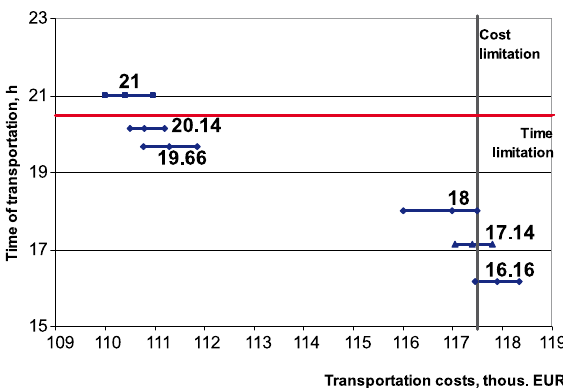
fig. 4. A general mathematical model for determining variability coefficient b of rail transport